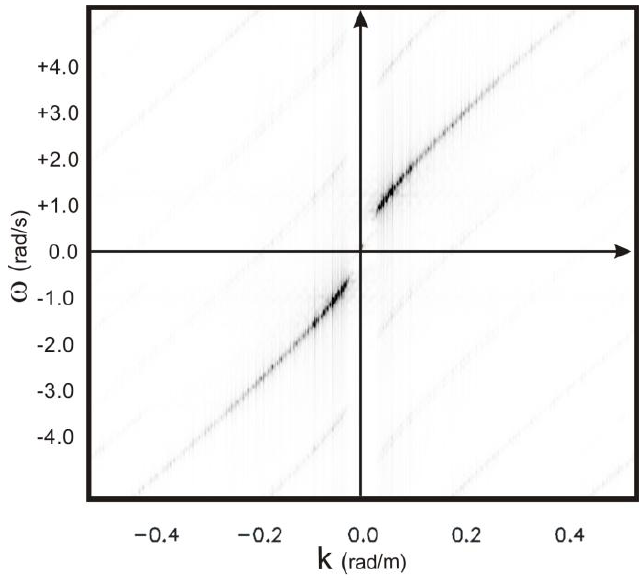
 (green line) and ),( tx  (red line), at the time NA A